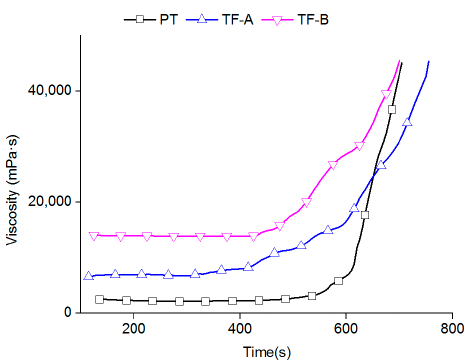
Figure 3. Viscosity of the three kinds of slurry.